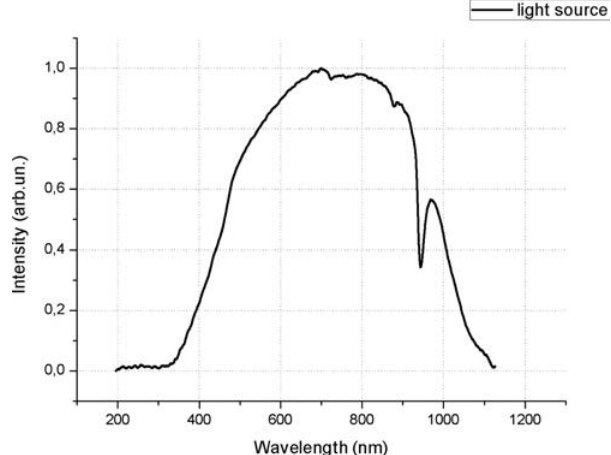
Fig. 2. The spectrum of the light source.